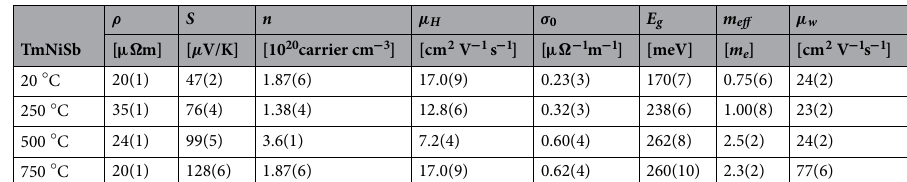
Table 2. Electrical resistivity, Seebeck coefficient, carrier concentration, Hall mobility, effective mass from parabolic band model near room temperature, as well as parameters obtained from least-squares fit of Eq. (1) to the resistivity data for TmNiSb specimens prepared at temperatures 20–750